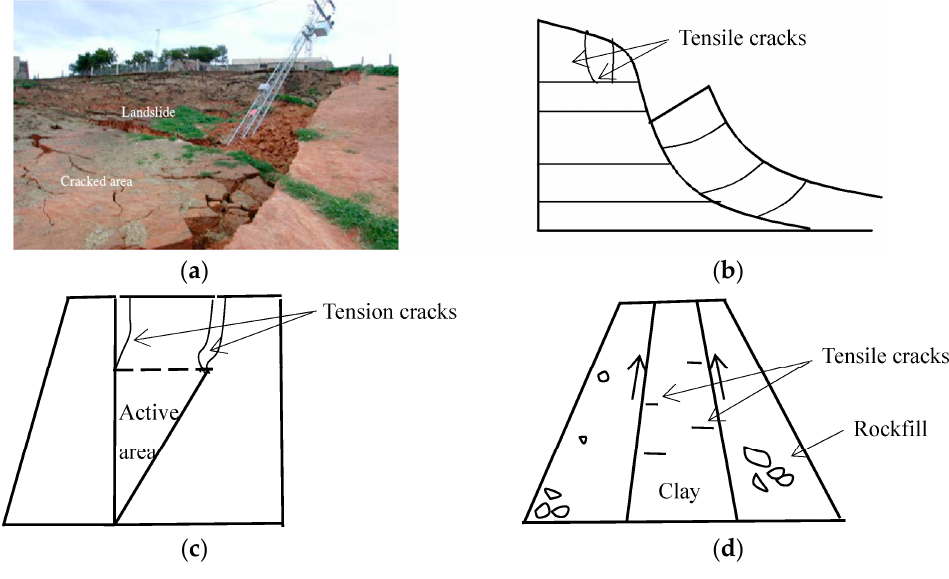
Figure 1. Various tensile cracks in engineering: ( a ) shrinkage cracks (H. Trabelsi et al., 2012); ( b ) tensile cracks on soil slope; ( c ) tensile cracks behind retaining wall; ( d ) tensile cracks in earth and rockfill dam.